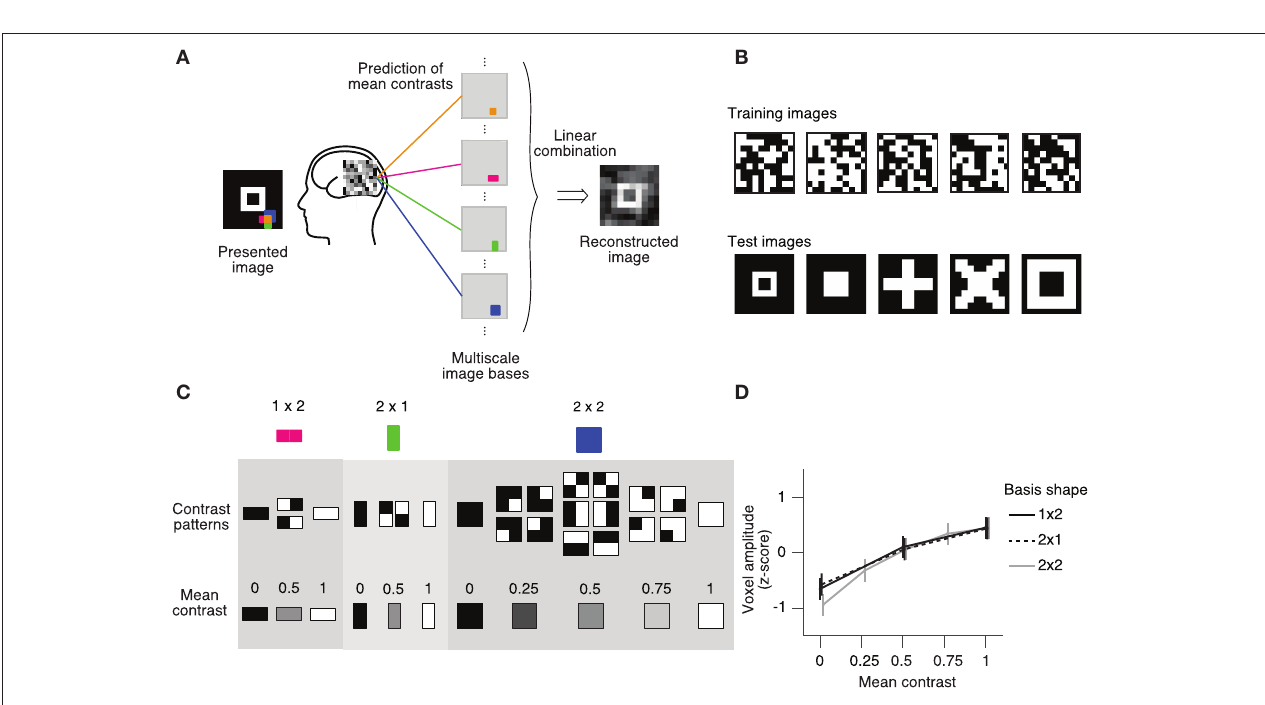
FIGURE 3 | Ordinal regression task with visual image reconstruction data. (A) Reconstruction procedure of Miyawaki et al. (2008). A presented image was reconstructed by first predicting the contrasts of image bases from brain activity and then optimally combining the image bases multiplied by the predicted contrasts. Image bases were 1 × 1-, 1 × 2-, 2 × 1-, and 2 × 2-shaped regions covering a 10 × 10-pixel image with overlaps (a total of 361 regions; 1 × 1, 100; 1 × 2, 90; 2 × 1, 90; 2 × 2, 81). (B) Examples of stimulus images. Random binary images (upper) and simple geometric shapes (lower) were respectively presented in the random image session and the figure image session of the experiment. In reconstruction analysis, data in the random image session were used to train decoders and data in the figure image session were used as test data. (C) Contrast patterns and mean contrast in image bases. 1 × 2- and 2 × 1-shaped regions took one of the four contrast patterns, and the mean contrast within the region took one of the three values (left, middle). 2 × 2-shaped regions took one of the 16 contrast patterns, and the mean contrast took one of the five values. (D) Relationship between the voxel amplitude and mean contrast. Voxels responsive to each local region were selected in a univariate analysis of the random image session data. The voxel amplitudes were then averaged across trials for each mean contrast. Error bars show the 95% confidence intervals across local regions.